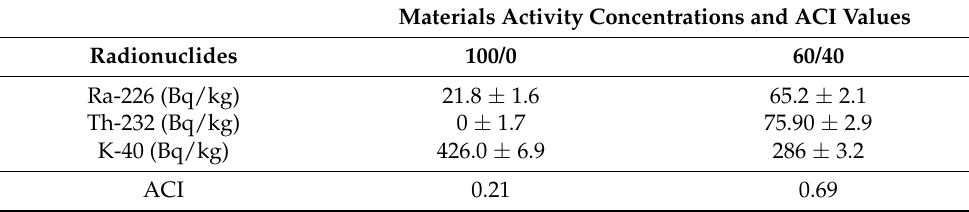
Table 6. Materials activity concentrations and ACI